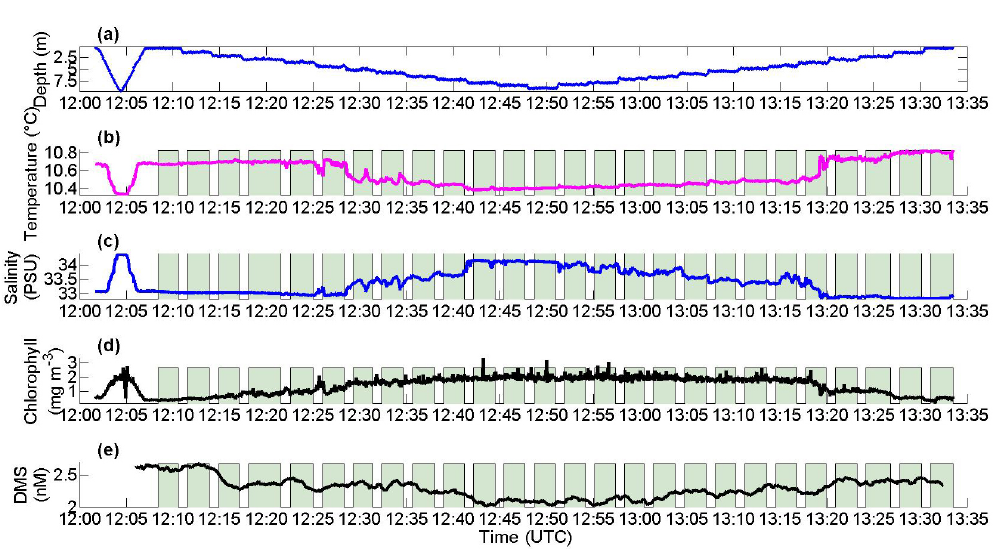
Figure 8. Time series measurements during an NSOP deployment in Plymouth Sound on 15 April 2014: depth (a) , temperature (b) , salinity (c) , chlorophyll fluorescence (d) and DMS ( sw ) (e) . Data used for depth bin analysis (Sect. 2.6) are identified by a shaded background. The beginning of the time series is an example of a continuous profile (see Sect.